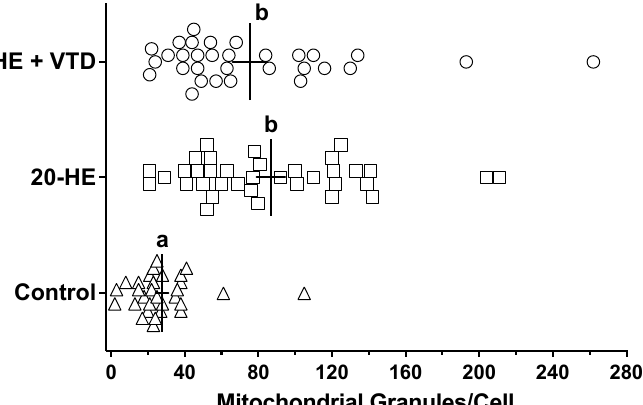
Figure 5. Distribution of mitochondrial granules per cell in Sf 21 cell cultures. Treatments were 0.1% DMSO (control), 42 µM 20-HE, and 42 µM 20-HE + 1 µM VTD. The vertical line for each group of symbols demarcates the mean with the SEM shown as a horizontal bisecting line. Statistical analysis used one-way ANOVA and a Tukey’s multiple comparison post-test. Bars not labeled by the same lower-case letter, indicate the statistical significance across treatments ( p < 0.0001). Sample size was at least n = 30 cells/treatment.